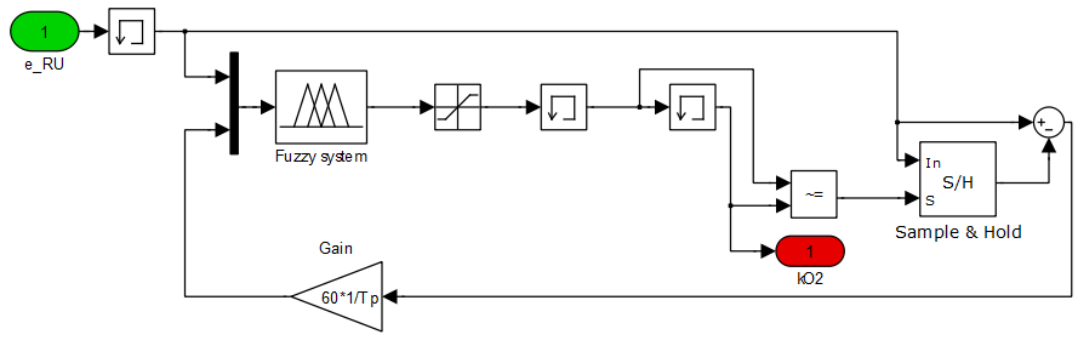
Figure 10. Fuzzy-logic-based procedure of oxygen flow determination.